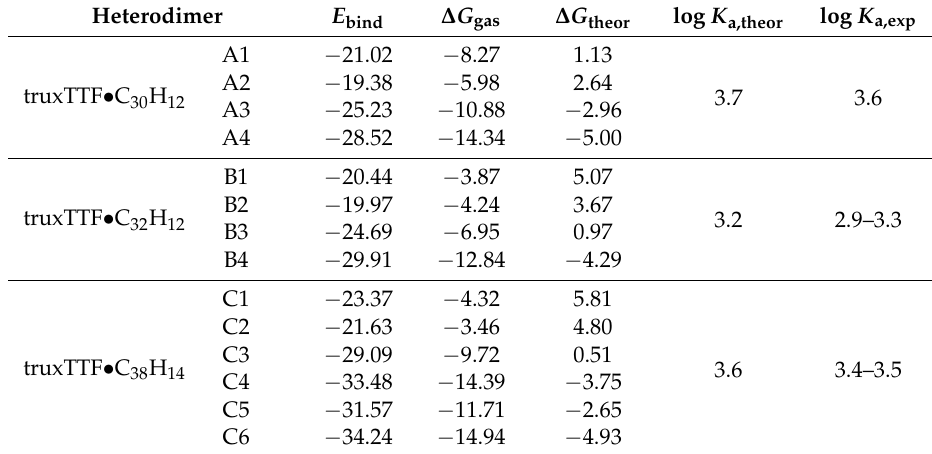
Table 7. Thermodynamic parameters (in kcal/mol) including binding energy ( E bind ), free energy in gas phase ( ∆ G gas ), and free energy including solvent effects ( ∆ G theor ) for the dimerization process. Theoretical and experimental log K a values are also included [19] 1